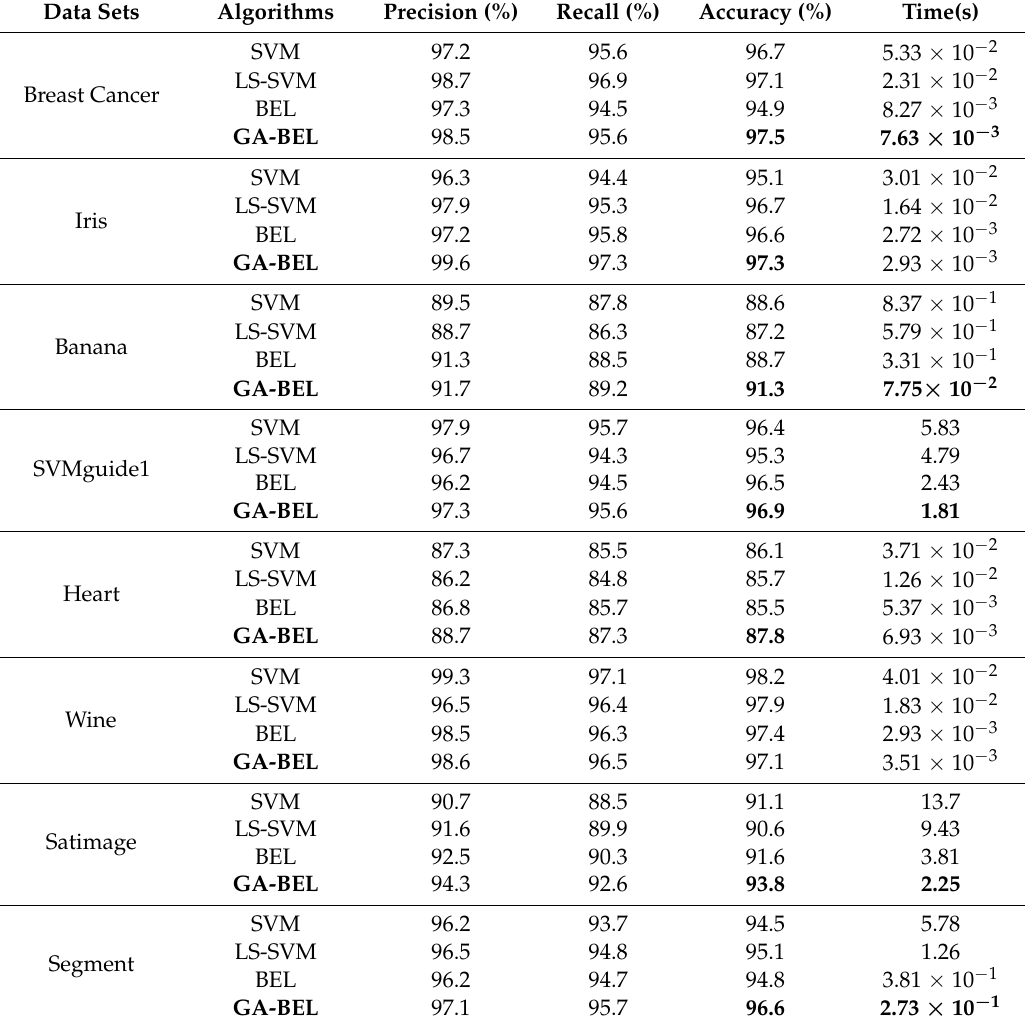
Table 4. Performance comparisons of different algorithms.